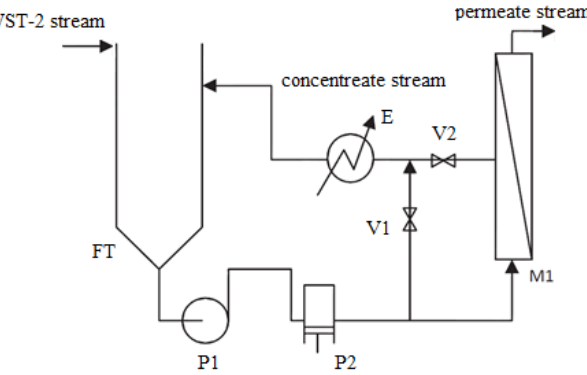
: bypass regulation valve; V 1 : membrane housing provided with SW membrane. 1